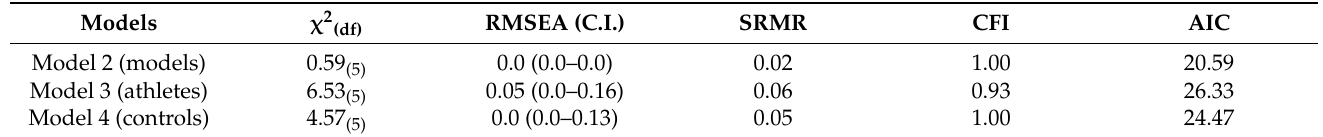
Table 4. Comparison between Model 2, 3 and 4.